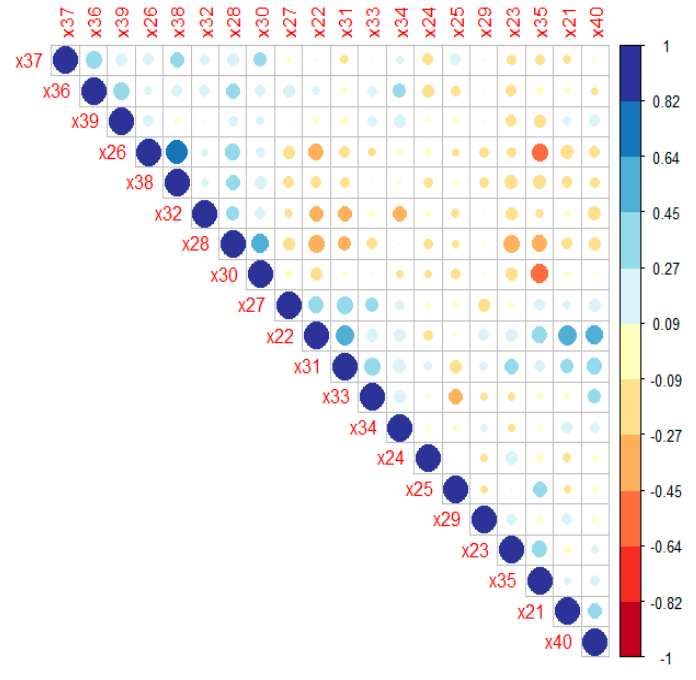
Figure 4. The graph of correlation matrix of sample leukemia genes. Table 6. The average percentage of accuracy and the average number of selected genes of lasso, adaptive lasso (AL), elastic net, and adaptive elastic net (AEN) under 20 leukemia genes.